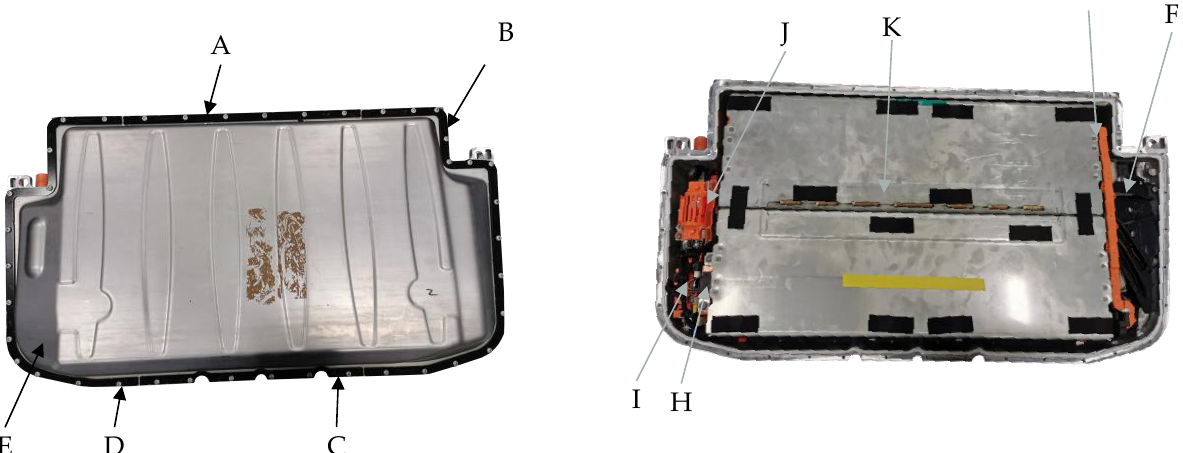
Figure 4. Picture of the disassembled PHEV battery system: A — clamping bar 1, B — clamping bar 2, C — clamping bar 3, D — clamping bar 4, E — cover, F — bus bar 1 (with integrated battery sensor), G — support strut, H — battery sensor (with shunt), I — bus bar 2, J — bus bar 3 (with integrated fuse), K —